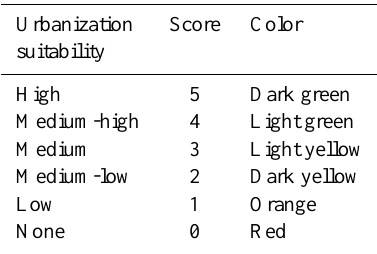
Table 2. Scores and colors assigned to the different urbanization